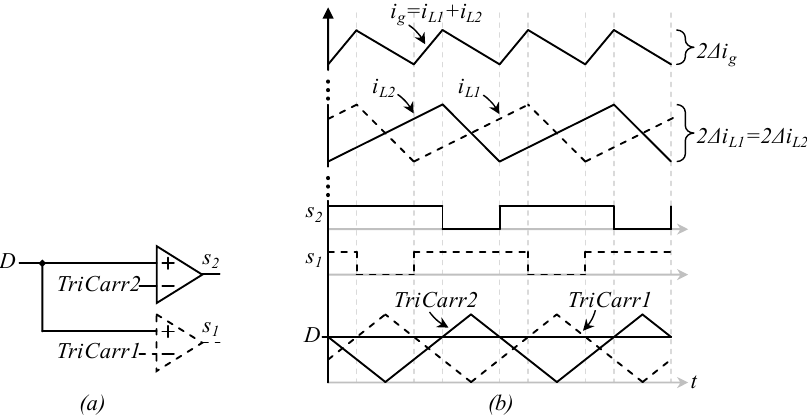
Figure 4. PWM scheme of the series-capacitor boost converter ( a ) block diagram with signals and comparators ( b ) important waveforms of the operation, input current i g , both currents through inductors i L 1 and i L 2 , switching functions s 1 and s 2 , and comparisons of the duty cycle D and triangular carriers TriCarr1 and TriCarr2 .